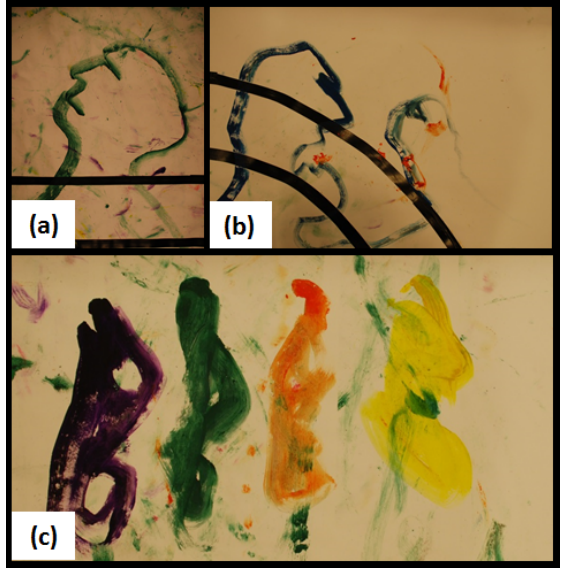
Figure 7. Examples of symbolic paintings by our robot. ( a ) Expressing basic relaxation ( b ) Mixed emotions: seeking to express anger (face on left), fear (face on right); sadness (via blue color); and overall negative valence (descending mood lines) ( c ) A progression from miserable on the left to joyful on the right, using highly abstracted